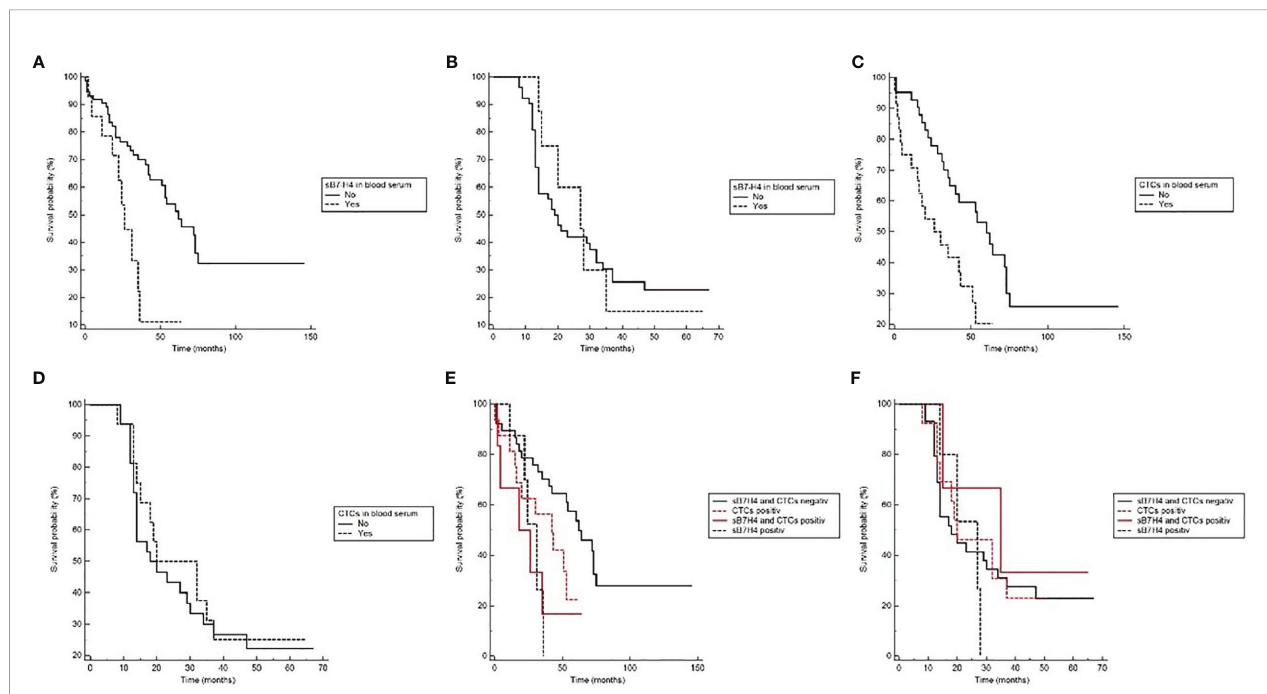
FIGURE 1 | The Kaplan-Meier plots showing prognostic relevance of sB7-H4 and CTC detection in blood serum. (A) Overall survival (OS) with regard to sB7-H4 detection (p=0.004). (B) Disease-free survival (DFS) with regard to sB7-H4 detection (ns). (C) Overall survival (OS) with regard to CTC detection (Log-rank p=0.008). (D) Disease-free survival (DFS) with regard to CTC detection (ns). (E) Overall survival (OS) for the different combinations of sB7-H4 and CTCs (Log-rank p=0.03). (F) Disease-free survival (DFS) for the different combinations of sB7-H4 and CTCs